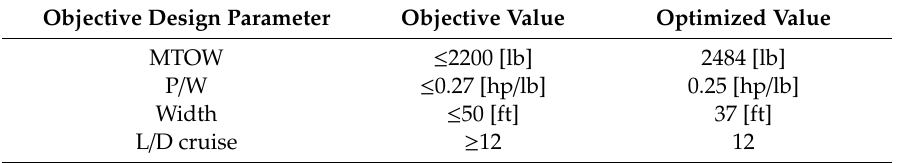
Table 22. Optimized design